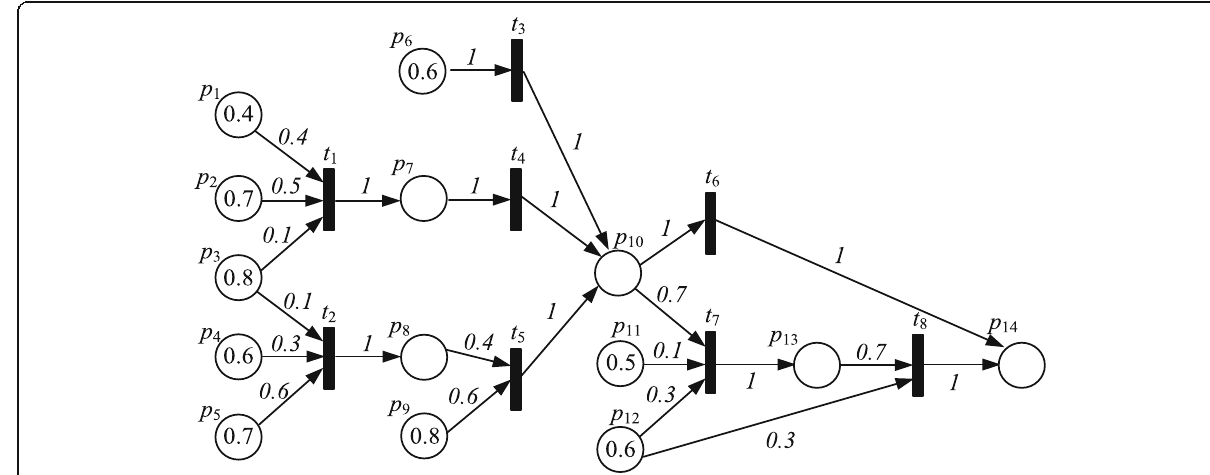
Fig. 8 Petri net modeling results for FTP attacks on 11 servers in the experimental